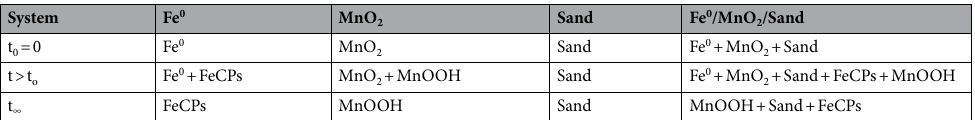
Table 2. Time-dependent inventory of reactive species in the four investigated systems. t 0 corresponds to the start of the experiment, while t ∞ corresponds to the time required for Fe 0 depletion. It is assumed that MnO 2 is quantitatively converted to MnOOH without impact on MB discoloration. FeCPs: Fe corrosion products. FeCPs can be free or coated on sand. (Adapted from ref. 70 ).